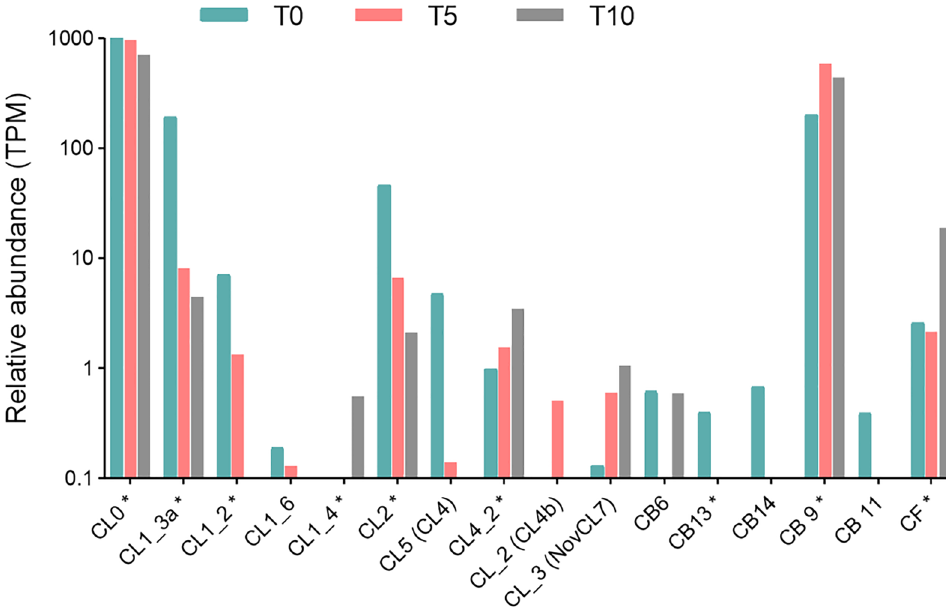
Figure 6. Relative expression of all transcripts coding cysteine cathepsins. Relative abundances (in TPM) are shown on a logarithmic scale. Isoforms marked by an asterisk were differentially expressed. Isoform CL1_3b was quantified only on protein level by LC–MS/MS. We used the Cwiklinski et al. 50 nomenclature. Alternative cathepsins’ names used in McNulty et al. 13 phylograms are shown in